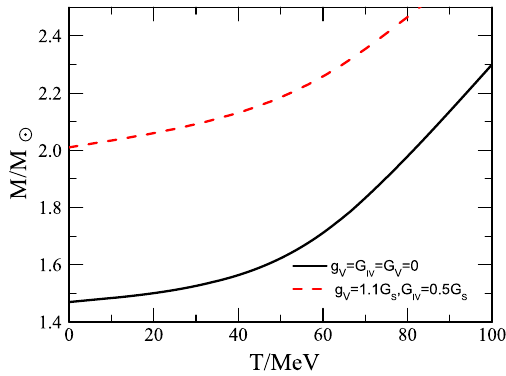
Fig. 5 The mass–radius relation for quark stars within SU(3) NJL model at different temperature constant within G IV = 0, G IV = 0 . 5 G S . It is observed